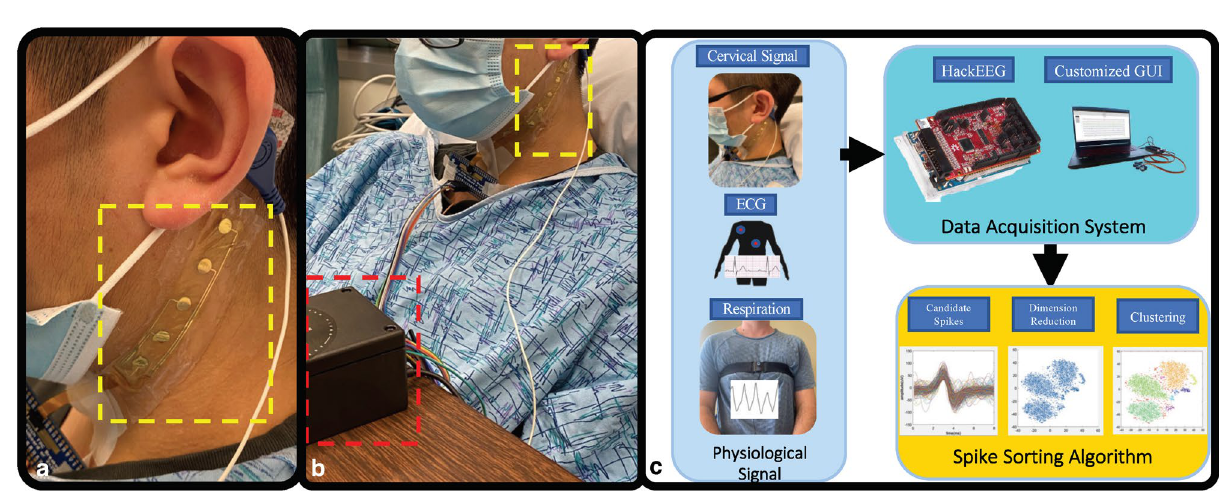
Figure 2. The custom design allows for free movement without distorting the adhesiveness and robustness of the physical structure of the electrode array. ( a ) The custom surface electrode array is adhesive integrated, flexible, and non-invasively attached to the subject’s anterior cervical neck, placed lateral to the trachea and medial to the sternocleidomastoid. A 3 M RedDot electrode was used as a reference electrode. The four channels were aligned rostral to caudal, so that each channel was positioned over an anatomical target: (1) channel #1 over the upper nodose ganglion, (2) channel #2 over the lower nodose ganglion, (3) Channel #3 over the upper carotid artery, and (4) channel #4 over the lower carotid artery. ( b ) Data collection was carried out with flexible multi-electrodes attached to the wireless biopotential data acquisition board, i.e., the HackEEG (red dashed outline), and 3 M RedDot deployed as ground/reference electrodes. ( c ) Subject recording pipeline and workflow. Cervical electroneurography, electrocardiography, and respiration were recorded; signals recorded to the data acquisition system underwent post processing